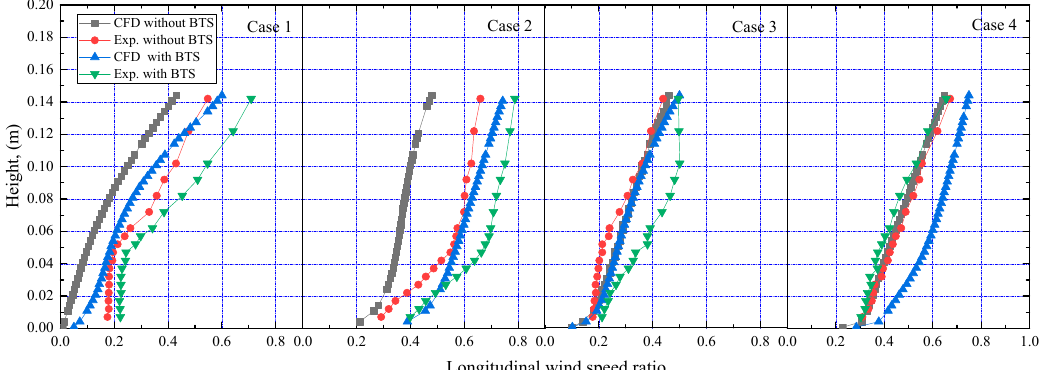
Figure 17. Numerical and experimental results of longitudinal wind speed ratio profiles at L/4.